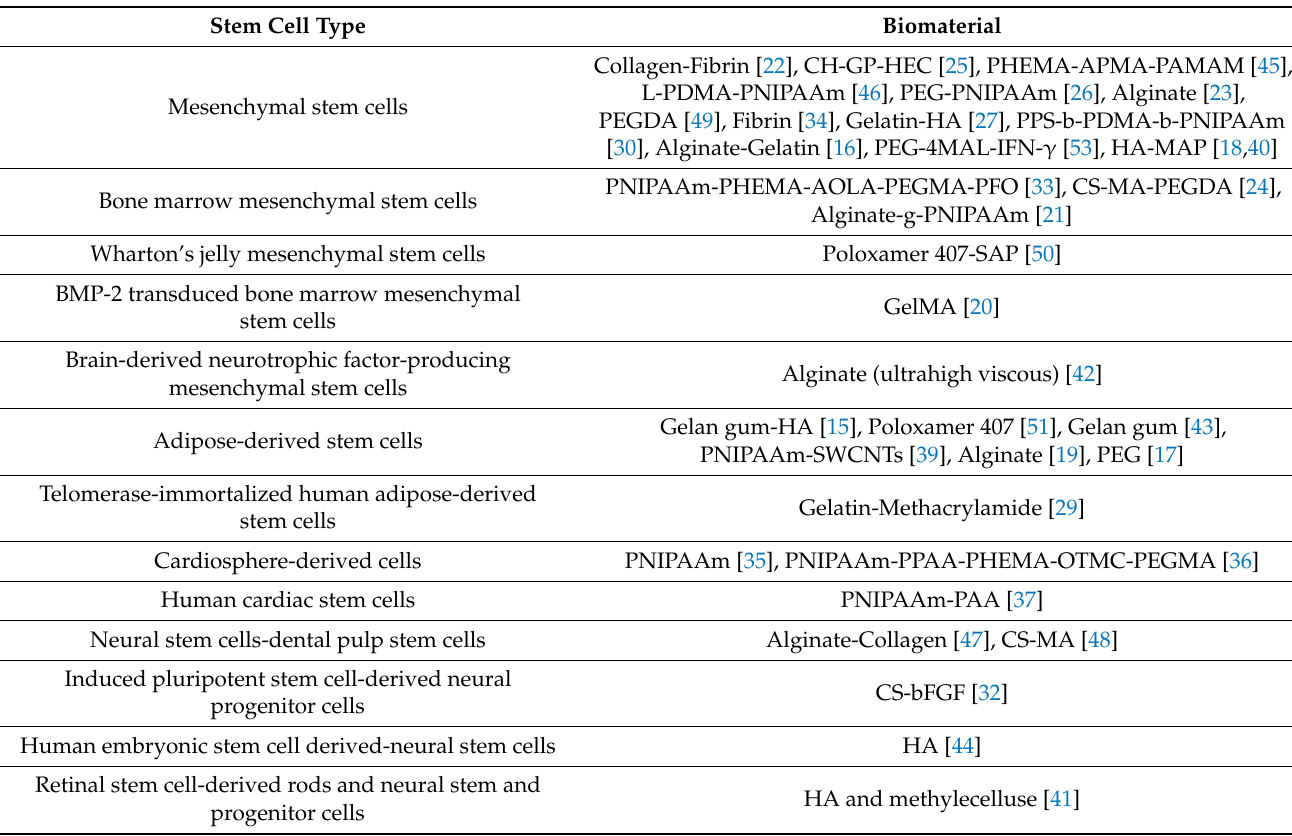
Table 2. Natural and synthetic biomaterials utilized for the encapsulation of different types of stem